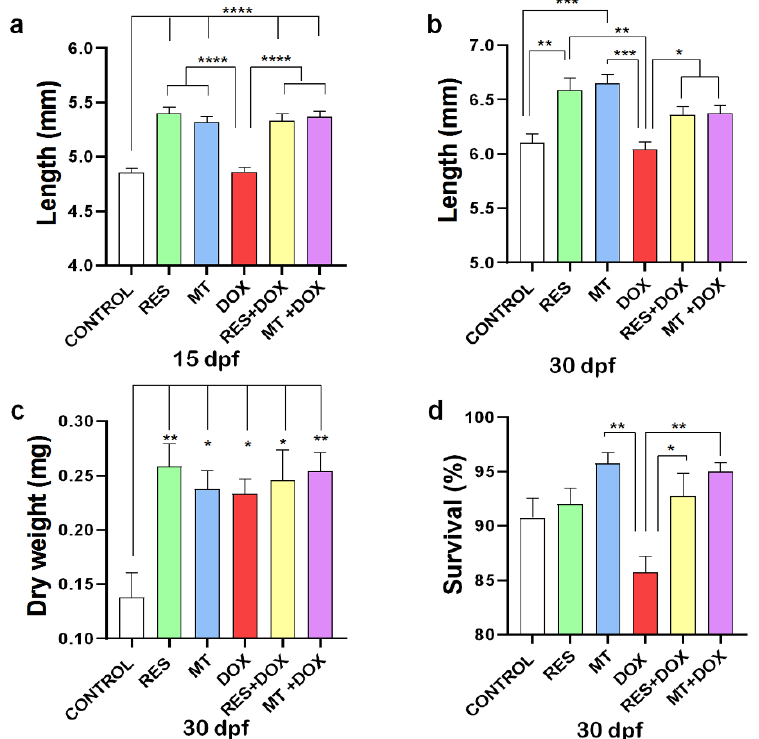
Figure 1. Growth and survival. Larvae were fed with resveratrol (RES), MitoTEMPO (MT) and doxorubicin (DOX) alone or in combination for 30 days. Total length of zebrafish larvae at 15 days post fertilization (dpf) (N = 25 × 4) ( a ) and 30 dpf (N = 25 × 4) ( b ), Dry weight at 30 dpf (N = 10 × 4) ( c ) and Survival at 30 dpf (N = 100 × 4) ( d ). Levels of significance were calculated using Tukey’s multiple comparisons (one-way ANOVA) [* p ≤ 0.05, ** p ≤ 0.01, *** p ≤ 0.001, **** p ≤ 0.0001].